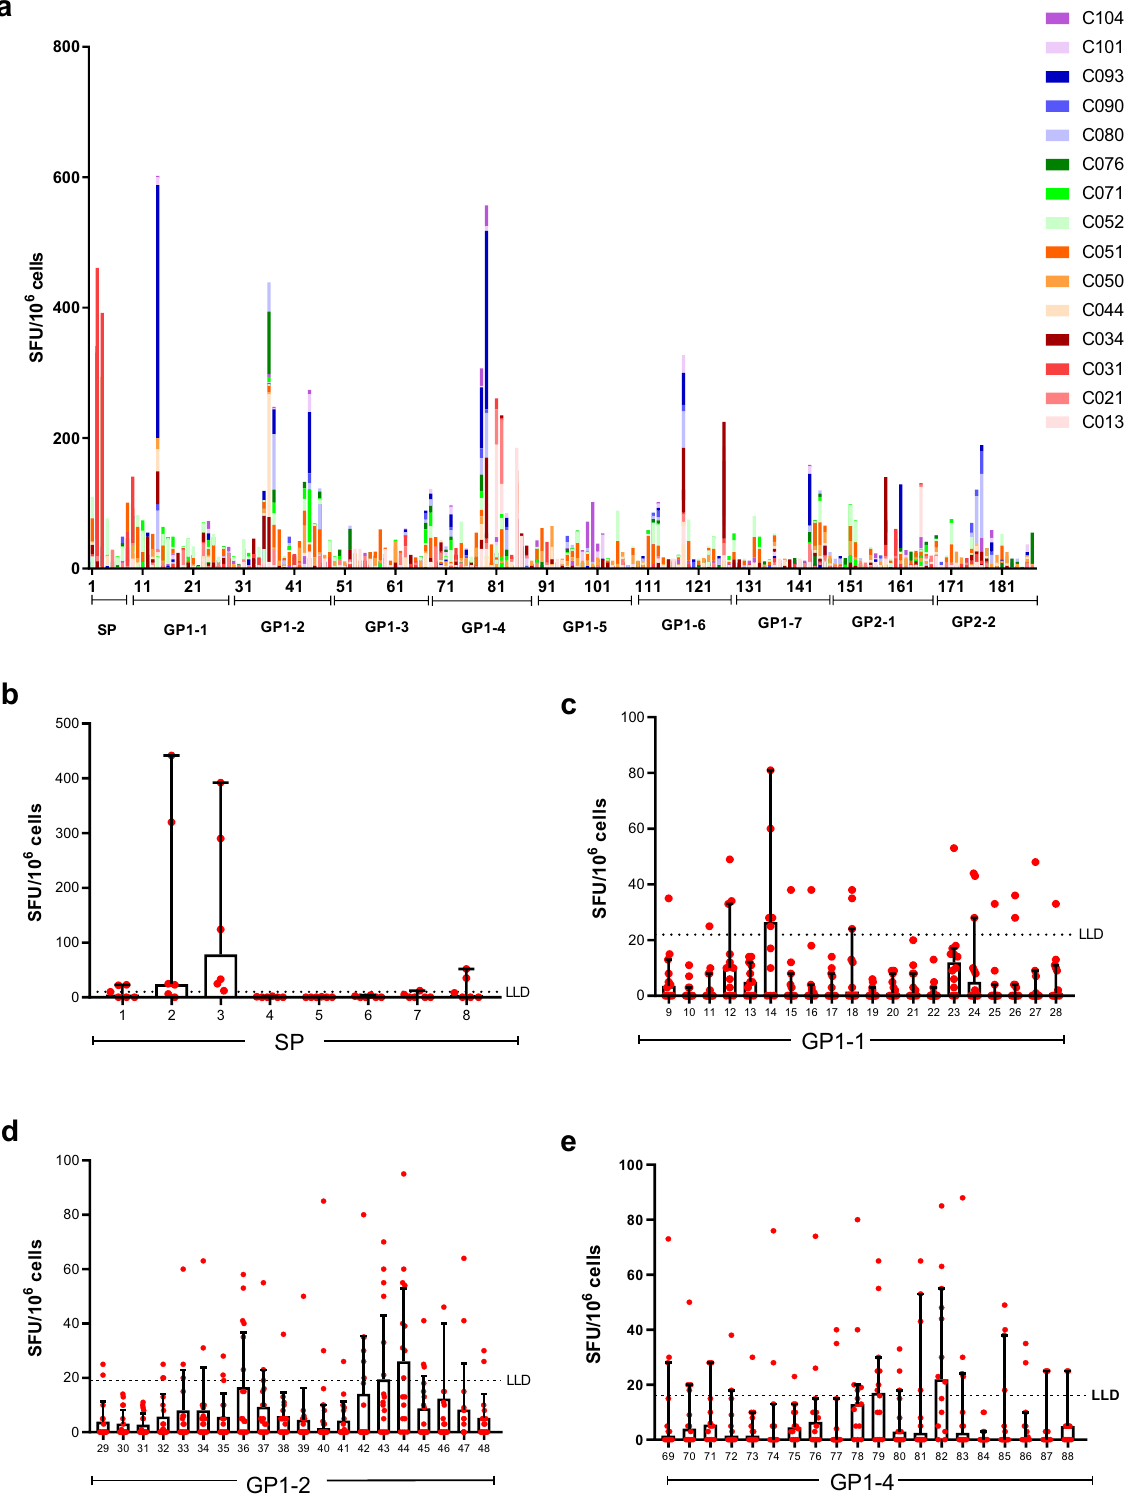
Fig. 2 Cellular immune response to EBOV GP peptides as measured by IFN γ ELISpot. a Response to 187 individual glycoprotein peptides amongst 15 fresh PBMC samples. Bars are stacked and indicate the sum of all results to each peptide amongst 15 EVD survivors. b Response amongst 6 EVD survivors to individual 15 mer peptides which make up the SP peptide pool. c The response amongst 12 EVD survivors to individual 15 mer peptides that make up the GP1-1 peptide pool. d Response amongst 18 EVD survivors to individual 15 mer peptides which make up the GP1-2 peptide pool. e The response amongst 14 EVD survivors to individual 15 mer peptides that make up the GP1-4 peptide pool. For graphs ( b – e ) red dots indicate individual data points and bars with error represent the median with the upper 95% con fi dence interval. Black dashed line represents the lower limit of detection (LLD) for the GP1-2 (19 SFU) or GP1-4 (16 SFU) peptide pool respectively, this was calculated using the mean of the negative samples plus three